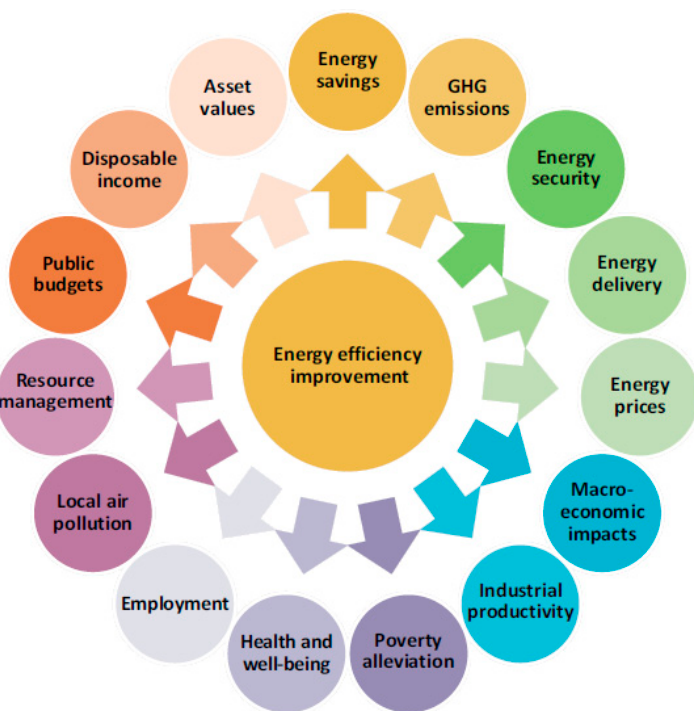
Figure 1. The benefits generated by the improvements in energy efficiency (IEA, 2014).